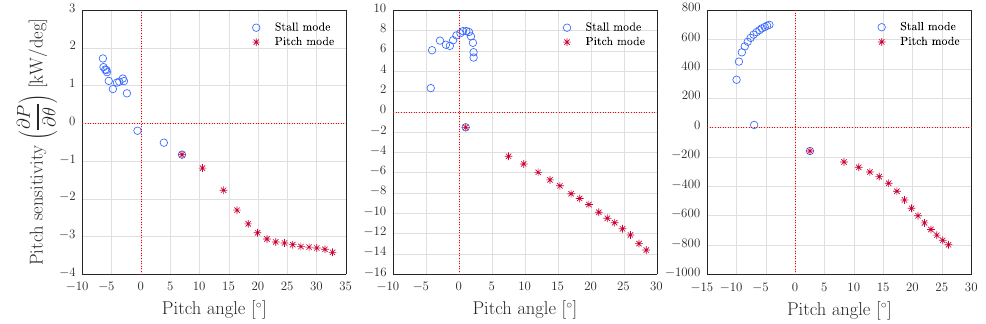
Figure 5. Pitch sensitivity ∂ P of the SWRT ( left ), UAE ( center ), and WP wind turbines ( right ) at wind ∂θ speeds in region